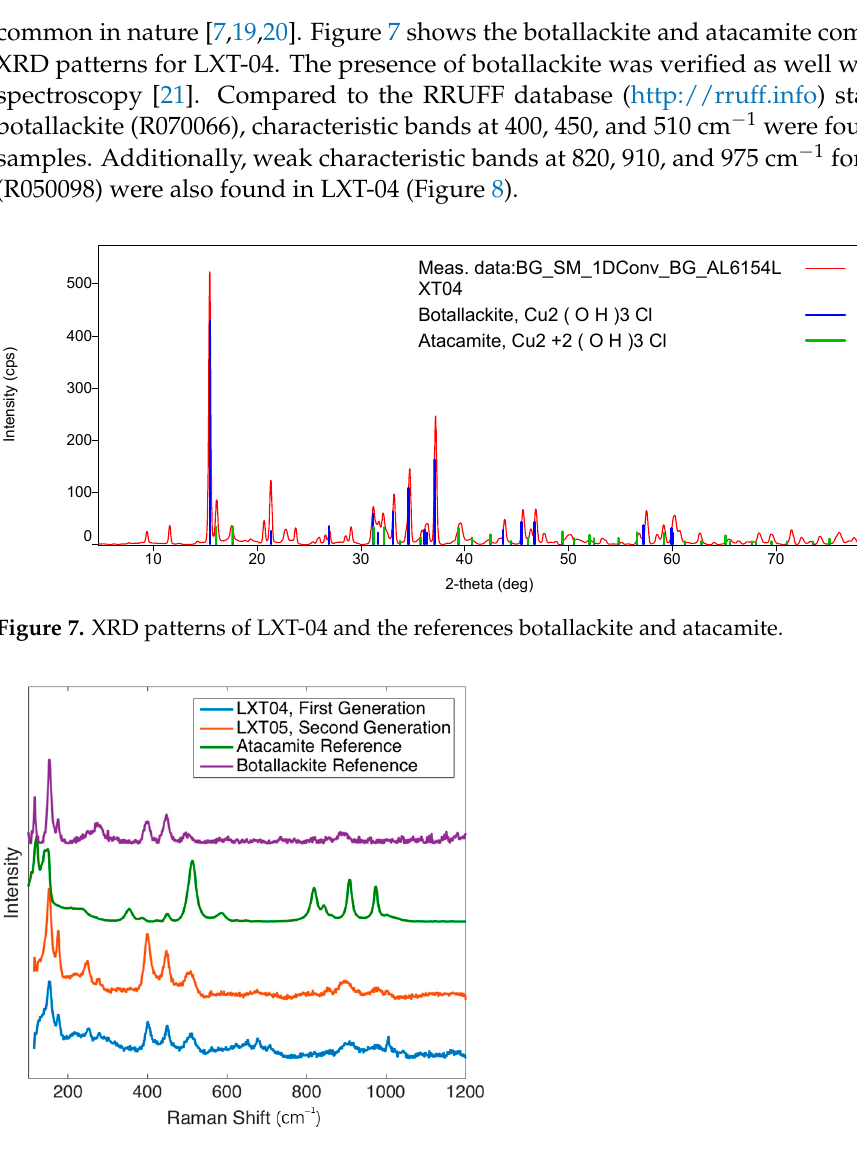
Figure 8. Raman spectra of LXT-04 and LXT-05 compared to reference spectra of atacamite and botallackite.